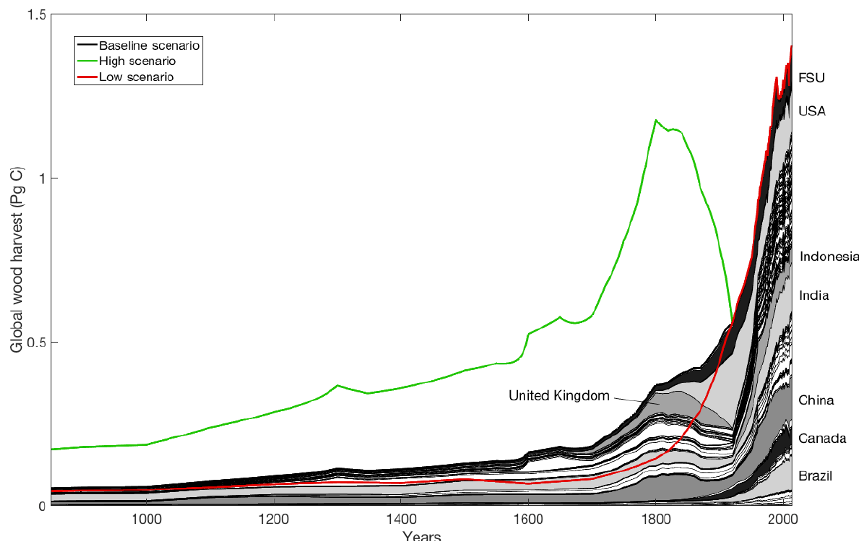
Figure 2. Annual national wood harvest (PgCyr − 1 ) for 850–2015 for the low, baseline, and high scenarios (FSU: former Soviet Union). Integrated total wood harvest in the baseline scenario was 259PgC (including